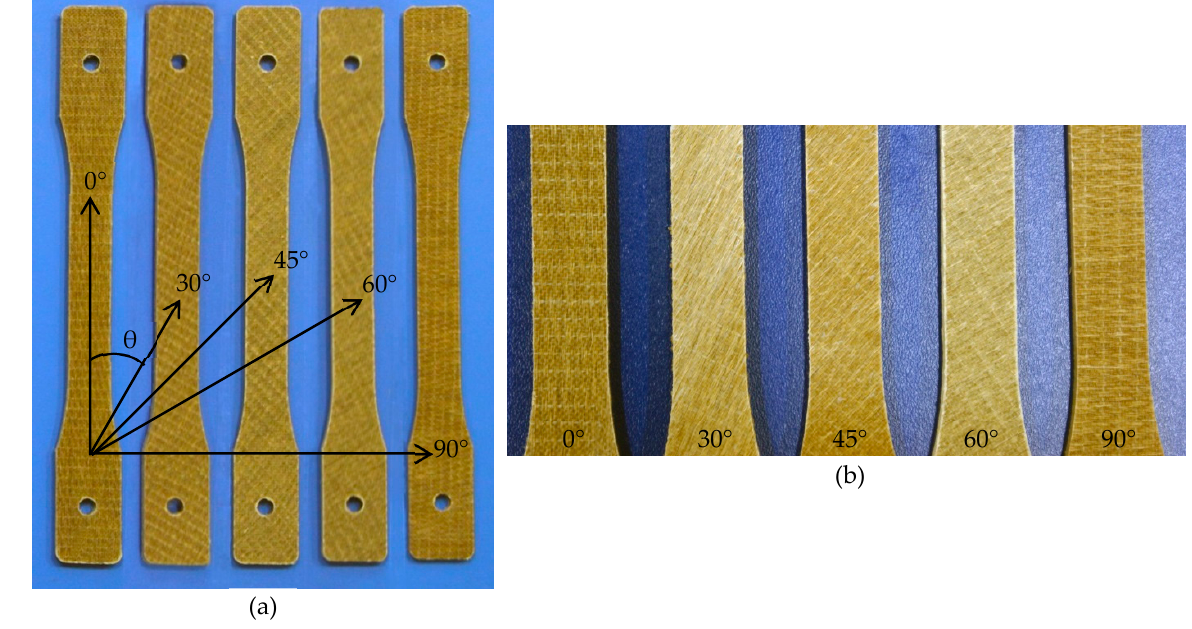
Figure 2. ( a ) Tensile samples with the fibre axis inclined at different angles to the testing direction